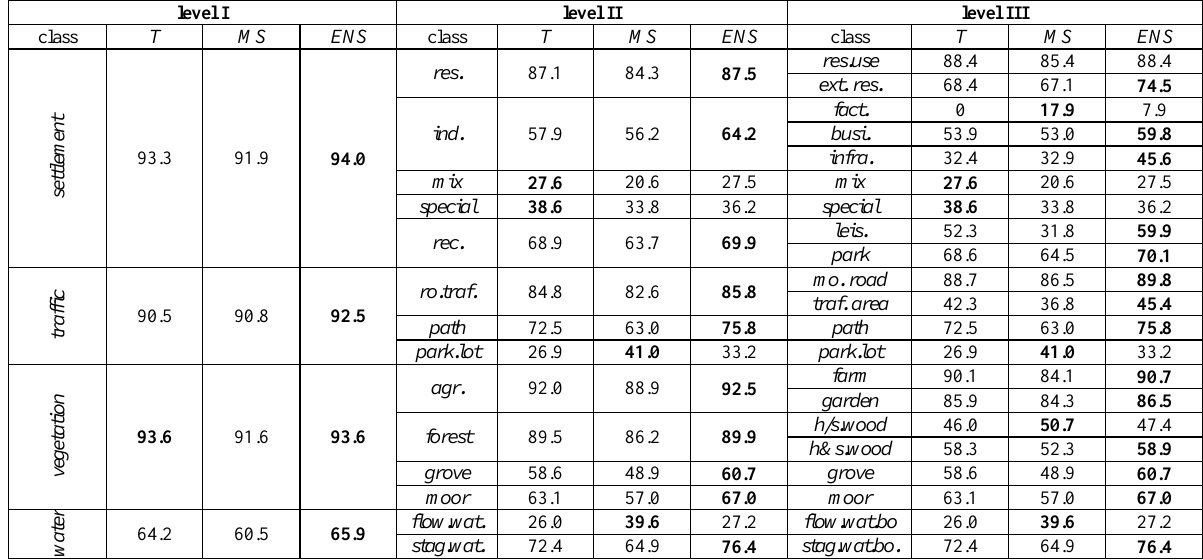
Table 4: F1 scores [%] for individual classes at all semantic levels in Schleswig, achieved by the three variants LuNet-lite-JO-T (T) , LuNet-lite-JO-MS (MS) and LuNet-lite-JO-ENS (ENS) . The best values per class are printed in bold